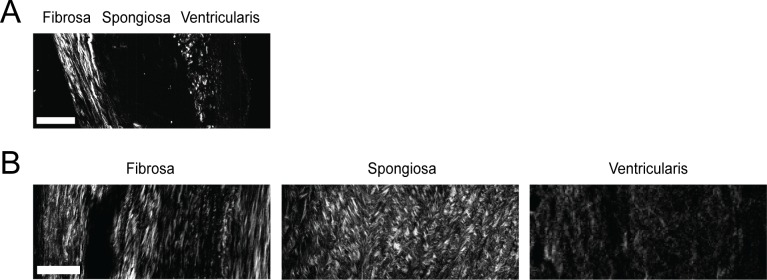
Visualization of collagen fiber microarchitecture using SHG microscopy.Representative images from (A) healthy and (B) diseased leaflets show microarchitectural changes in collagen in the fibrosa and spongiosa. Scale bar = 50 μm.